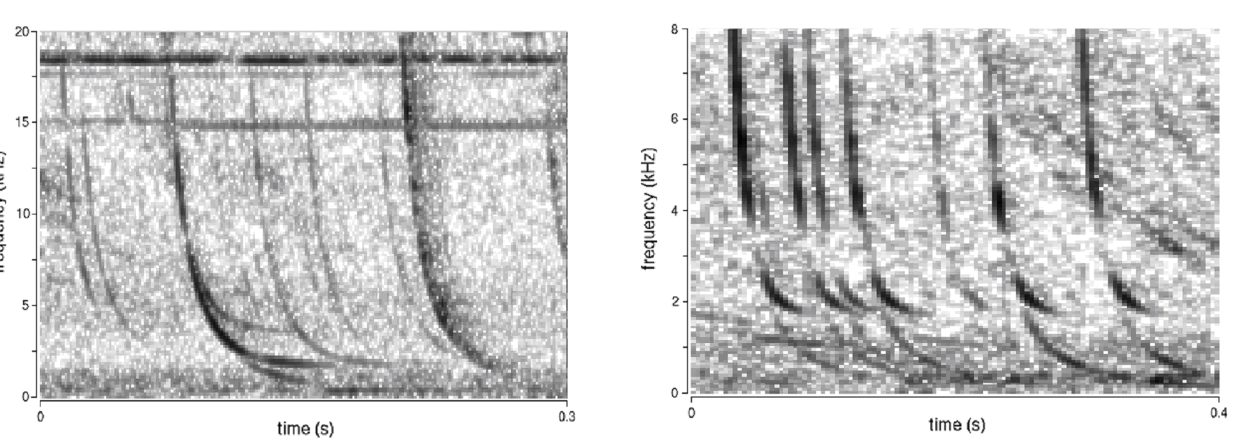
Fig. 2. Fractional hop whistler traces, exhibiting the spiky feature has a similar dispersion to surrounding, conventional ones (orbit: 683 up, sensor: E34, date: 18 August 2004, 10:37:09.8 UT, satellite position: 31.5S; 179.2E, altitude: 733.3, L: 1.7).